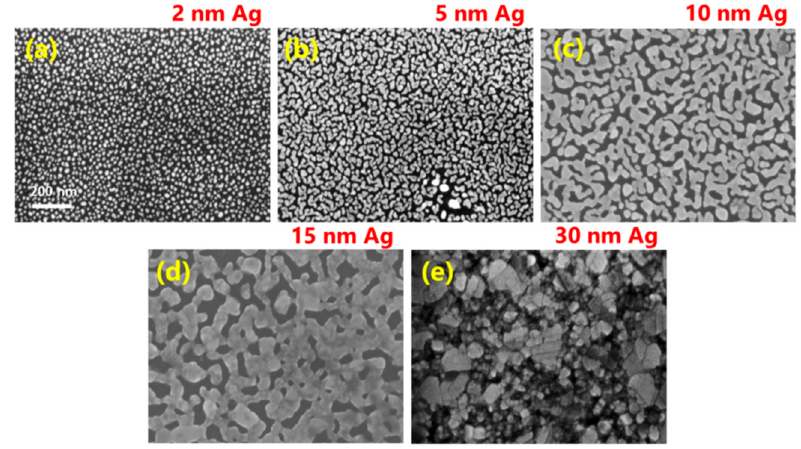
Figure 9. SEM images of MLG-supported silver films of different thickness: ( a ) 2 nm, ( b ) 5 nm, ( c ) 10 nm, ( d ) 15 nm, and ( e ) 30 nm, respectively [47]. Copyright 2019 Elsevier B.V., Amsterdam, Netherlands.